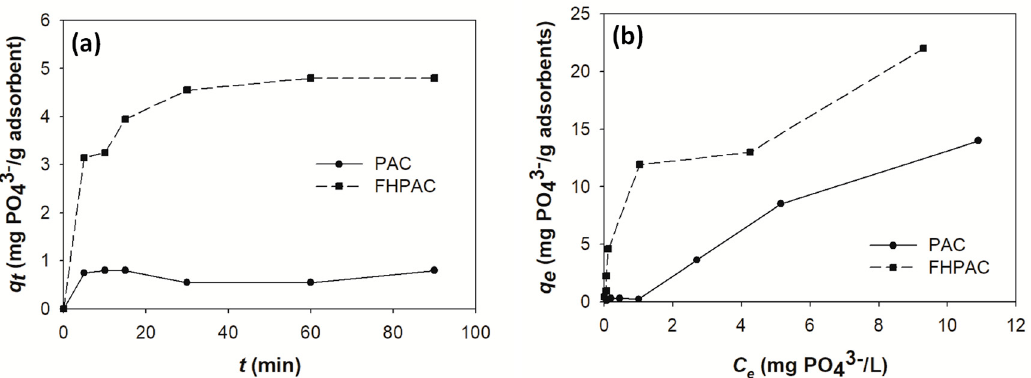
Figure 3. ( a ) Adsorption kinetics of phosphate onto PAC and FHPAC, and ( b ) adsorption isotherms of phosphate onto PAC and FHPAC.